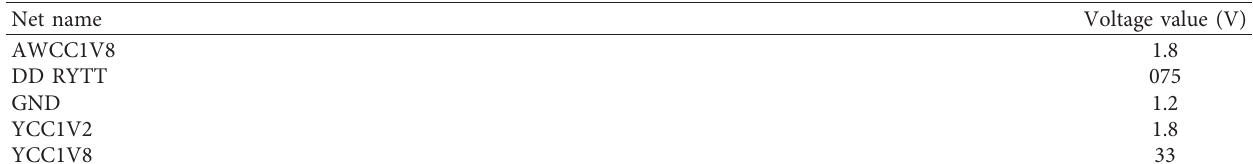
Table 5: Before the simulation, you need to specify specific voltage values for the power signal and ground.